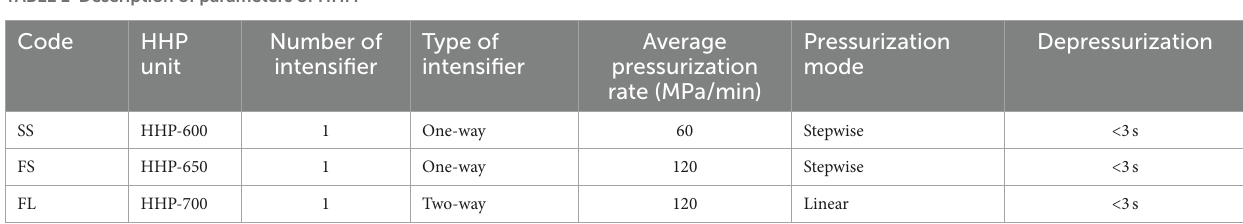
TABLE 1 Description of parameters of